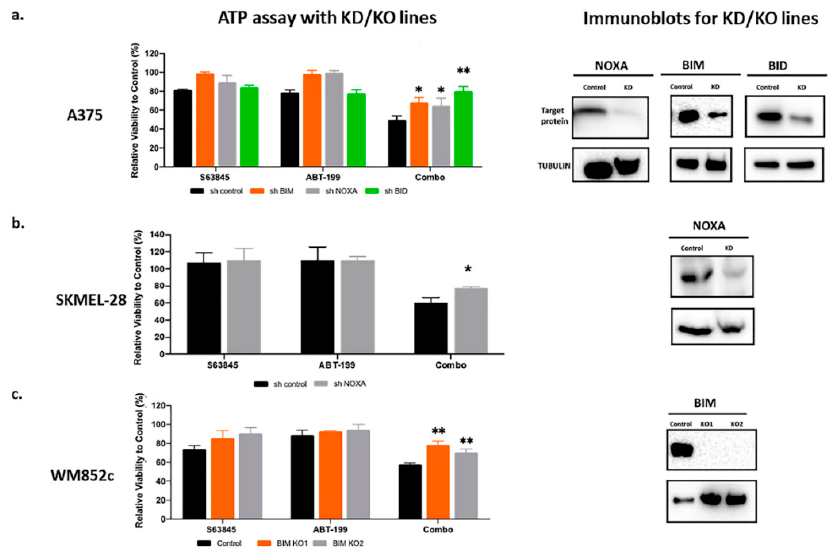
Figure 5. The combination-induced cell death was partially dependent on NOXA, BCL2-like 11 (apoptosis facilitator) (BIM) or BID. ATP assays with knockdown (KD) or knock out (KO) of indicated cells to test if the KD / KO protects against combination-induced cell death. Immunoblot to show the knockdown or knockout of NOXA, BIM or BID. ( a ) KD lines for NOXA, BIM, or BID in A375. ( b ) KD lines for NOXA in SKMEL-28. ( c ) BIM KO lines in WM852c. * indicates p < 0.05; ** indicates p < 0.01. Error bars represent +/ − SEM.